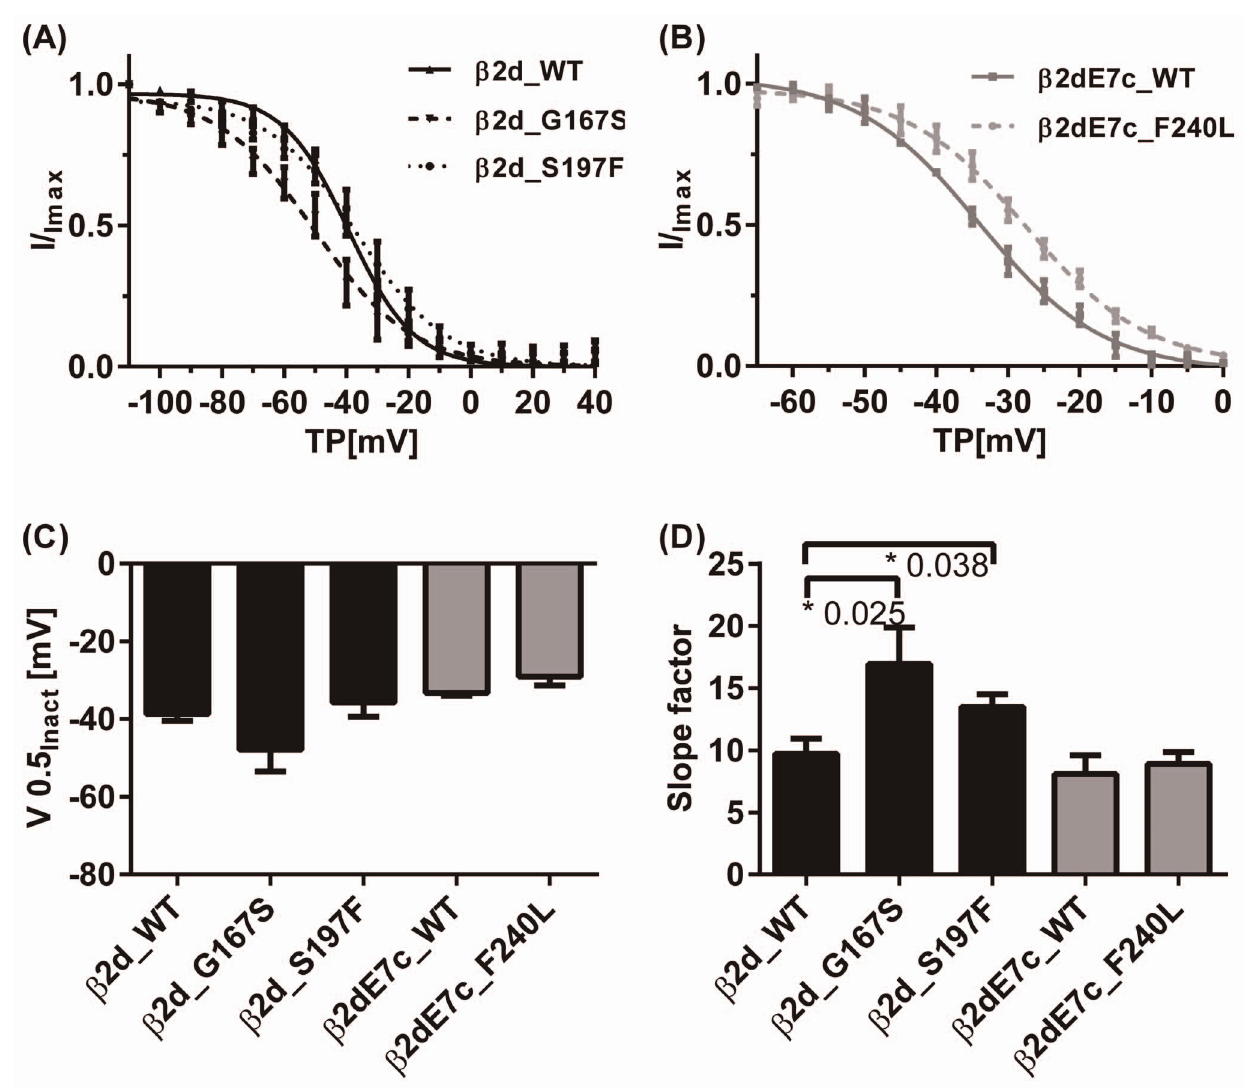
Figure 4. Voltage-dependent steady-state inactivation (a, b) of Ba 2 + currents through L-type calcium channels. The ASD mutants p.G167S (N=4) and p.S197F (N=6) showed a significantly flattened slope of voltage-dependent inactivation compared to b 2d_WT (N=7). The third mutation b 2dE7c_F240L. (N=5) did not obviously differ from its corresponding b 2dE7c_WT (N=2). Half-inactivation potentials (V0.5 inact ) ( c ) and the slope factors dV ( d ) were obtained from the fits of individual experiments using the Boltzmann equation and averaging the results. Asterisk (*) marks a statistical significance (P , 0.05) compared to the respective WT.